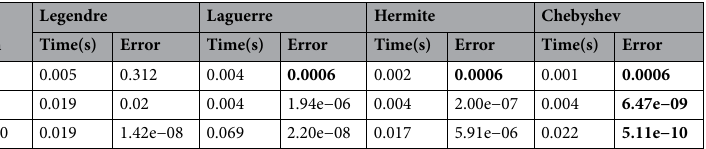
Table 11. Comparision of maximum relative error of z 2 ( t ) for Example 7.2 with different numbers of neurons. Significant values are in